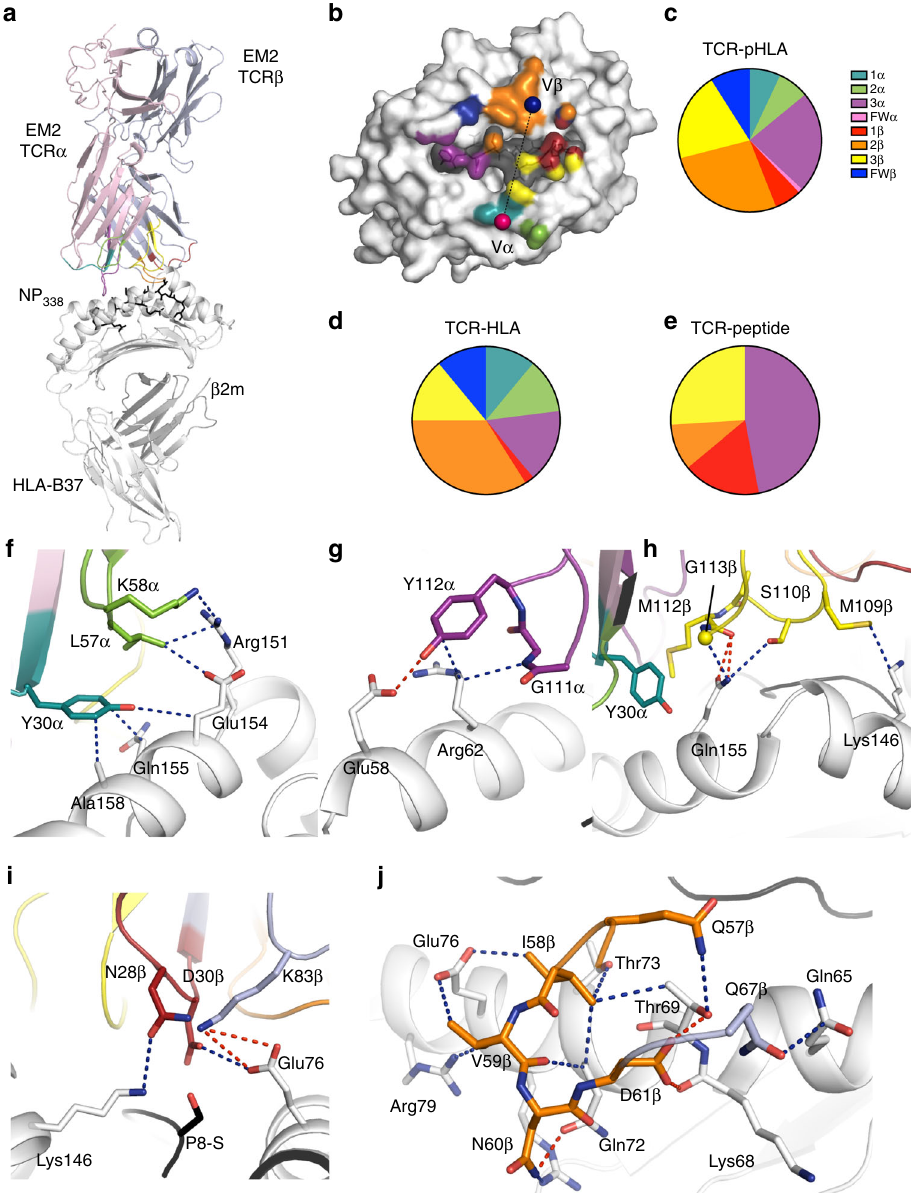
Fig. 6 Structure of EM2 TCR in complex with the HLA-B37-NP 338 . a Overview of the EM2 TCR ( α -chain in pink and β -chain in blue) bound to the HLA-B37- NP 338 complex (HLA in white and peptide in black). b The EM2 TCR-binding footprint on the HLA-B37 surface (white) and NP 338 peptide (gray surface) is represented by the atomic contact made by each TCR residues colored in teal, green, and purple for the CDR1, 2, and 3 of the α -chain; red, orange, and yellow for the CDR1, 2, and 3 of the β -chain; and pink and blue when contacted by the framework residue of the α - and β -chain, respectively. The pie charts represent the buried surface area at the interface between c the TCR with the HLA-B37-NP 338 or with d HLA-B37 alone or e with the peptide alone. The different colors represent the TCR gene segment as per b . Interaction of the EM2 TCR with the HLA-B37 molecule (white) are represented for f CDR1 α and CDR2 α ; g CDR3 α ; h CDR3 β ; i CDR1 β and FW β ; and j for CDR2 β . The same color scheme is used as per b for the different segments of the TCR. The sphere represents the C α atom of glycine residue, the blue dashed lines represent hydrophobic interaction, while the red dashed lines indicated hydrogen bond or salt was then determined using multiplex RT-PCR (Fig. 8b). Two of the HLA-A1-restricted NP 44 peptide (Fig. 8). Conservation ana- the three donors (Donors 1 and 20) had both NP 44 - and NP 44 - lysis revealed that there were two major variants of the peptide, the CTELKLSDY (NP 44 ) and the S7N mutant CTELKLNDY S7N-speci fi c CD8 + T cell populations. Interestingly, Donor 21 (NP 44 -S7N), covering 34 – 100% of H3N2, H7N9, H5N1, and had only a NP 44 -speci fi c CD8 + T cell population, with no H1N1 virus strains (Supplementary Table 7). To investigate detectable S7N-speci fi c CD8 + T cell population (Fig. 8b). A cross-reactivity towards these variant NP 44 peptides, PBMCs predominant TRAV8-2 + TCR α chain expressing a CDR3 α from healthy HLA-A1 + donors ( n = 3) were tetramer stained sequence CVVSDRNFNKFYF paired with multiple distinct with each of the NP 44 variants directly ex vivo and magnetically TCR β s and was detected in two out of three donors (Supple- enriched and single-cell sorted (Fig. 8a). The TCR αβ repertoire mentary Table 8). Similar to the NP 338 system, speci fi c clonotypes